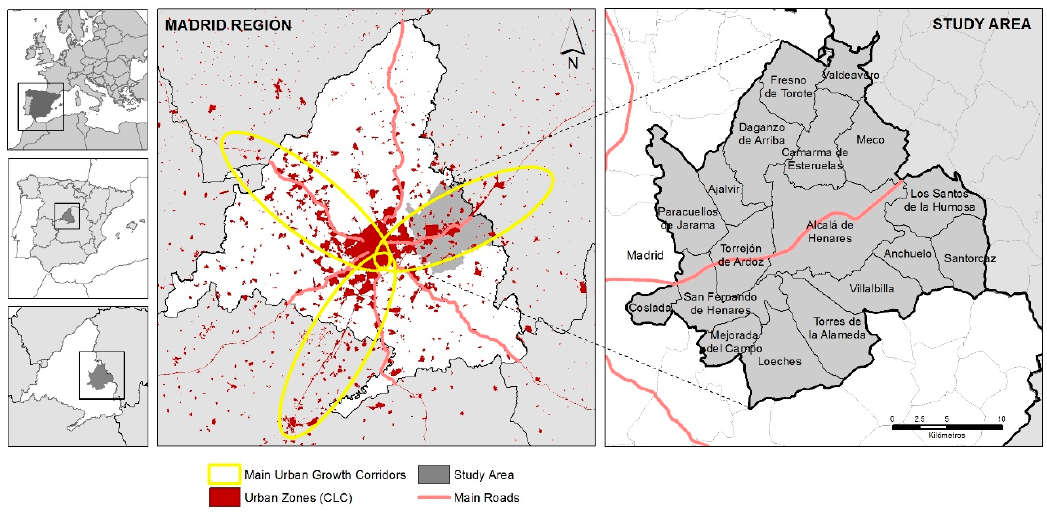
Figure 1. Urban corridors in the region of Madrid and study area.